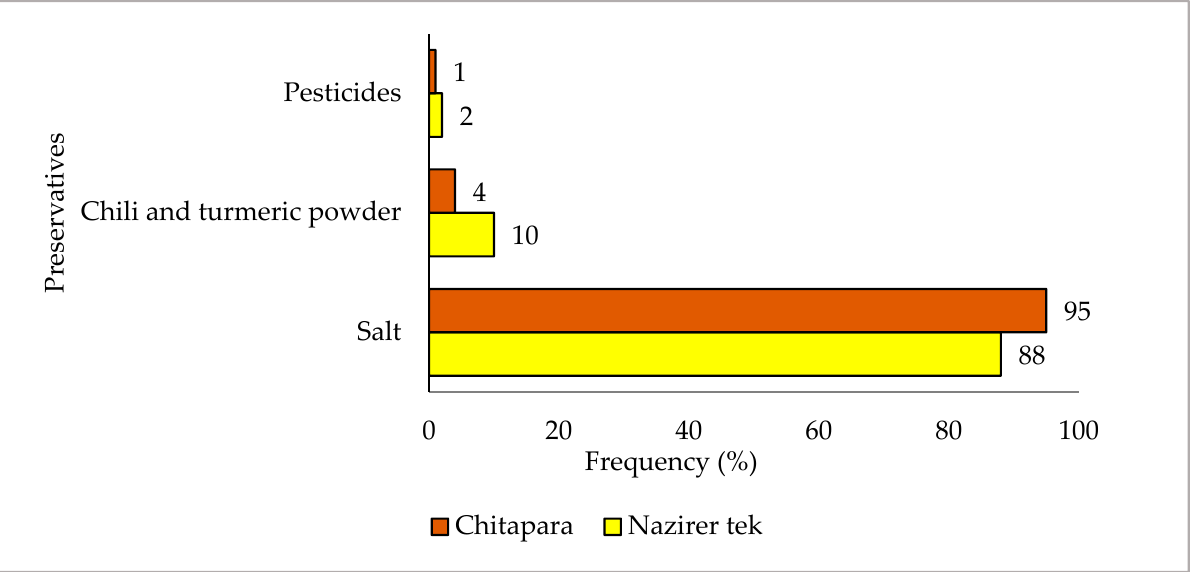
Figure 8. Frequency of using preservatives during fish drying and processing.